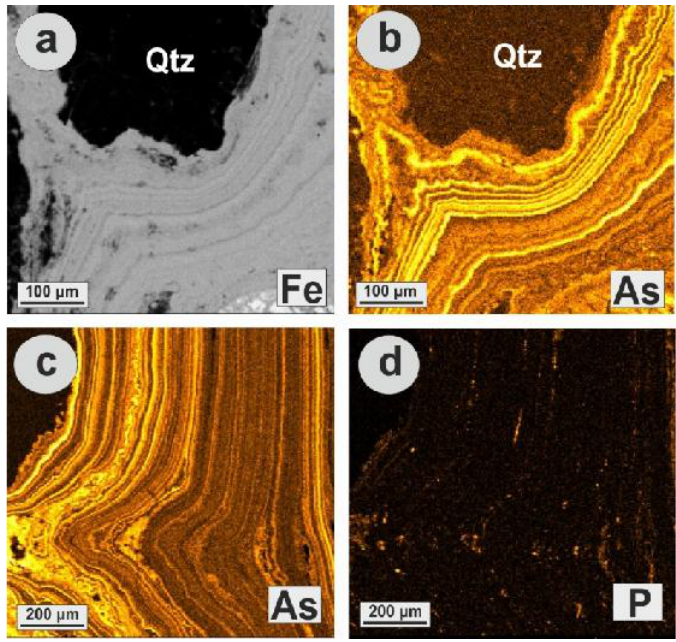
Figure 7. X‐ray element mapping showing the distribution of Fe‐As ( a , b ), and As and P ( c , d ) in Figure 7. X-ray element mapping showing the distribution of Fe-As ( a , b ), and As and P ( c , d ) in colloform pyrite I. Positive P anomalies in pyrite are related to micro‐inclusions of apatite colloform pyrite I. Positive P anomalies in pyrite are related to micro-inclusions of apatite (ML27CC).